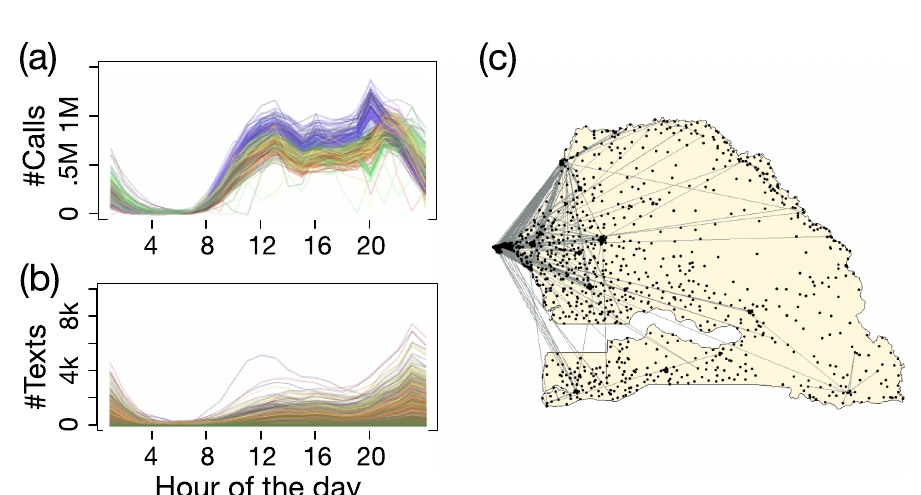
Fig 1. Mobile phone activity profiles and network structure. (a) Number of calls per hour aggregated at national level for each day of the year. (b) Yearly average of the number of texts per hour of the day sent from each tower. (c) Network structure limited to edges corresponding to at least 2000 text messages sent in